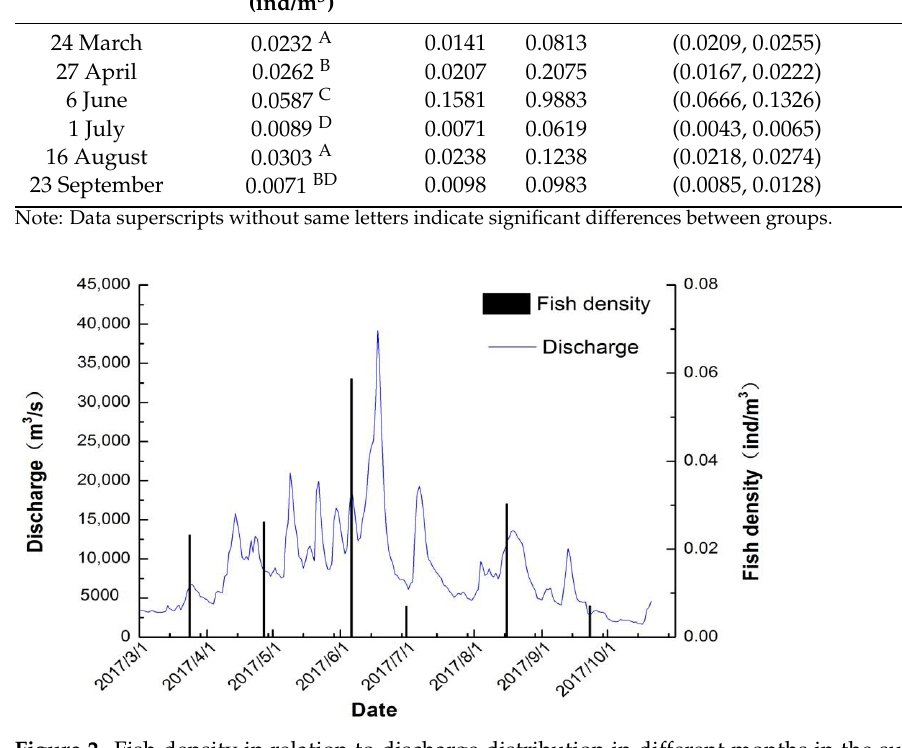
Figure 2. Fish density in relation to discharge distribution in different months in the survey area downstream of the Changzhou Dam.